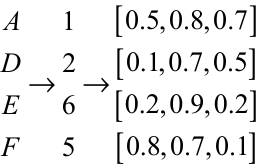
Figure 2. The overall workflow of ACPNet. The manually selected features and auto-embedding features are fed to a fully con- nected neural network (Dense Network) and recurrent neural network (RNN) [21] respec- tively, and then the result of the previous process is merged for the final prediction. Over- all, ACPNet combines Dense Network and RNN to construct a hybrid deep learning- based model to identify ACPs, which not only consider the importance of manually se- lected features but also automatically learn the potential features from raw peptide se- quences as well. Prediction Model Constructed by RNN and Dense Networks RNN and Dense network, as the two most significant deep learning models, are widely applied on time serial and feature independent issues respectively. LSTM [22], a kind of implementation of RNN, is usually employed to further automatically extract po- tential features from the time serial vectors. The kernel process of LSTM can be illustrated by Equation (5).